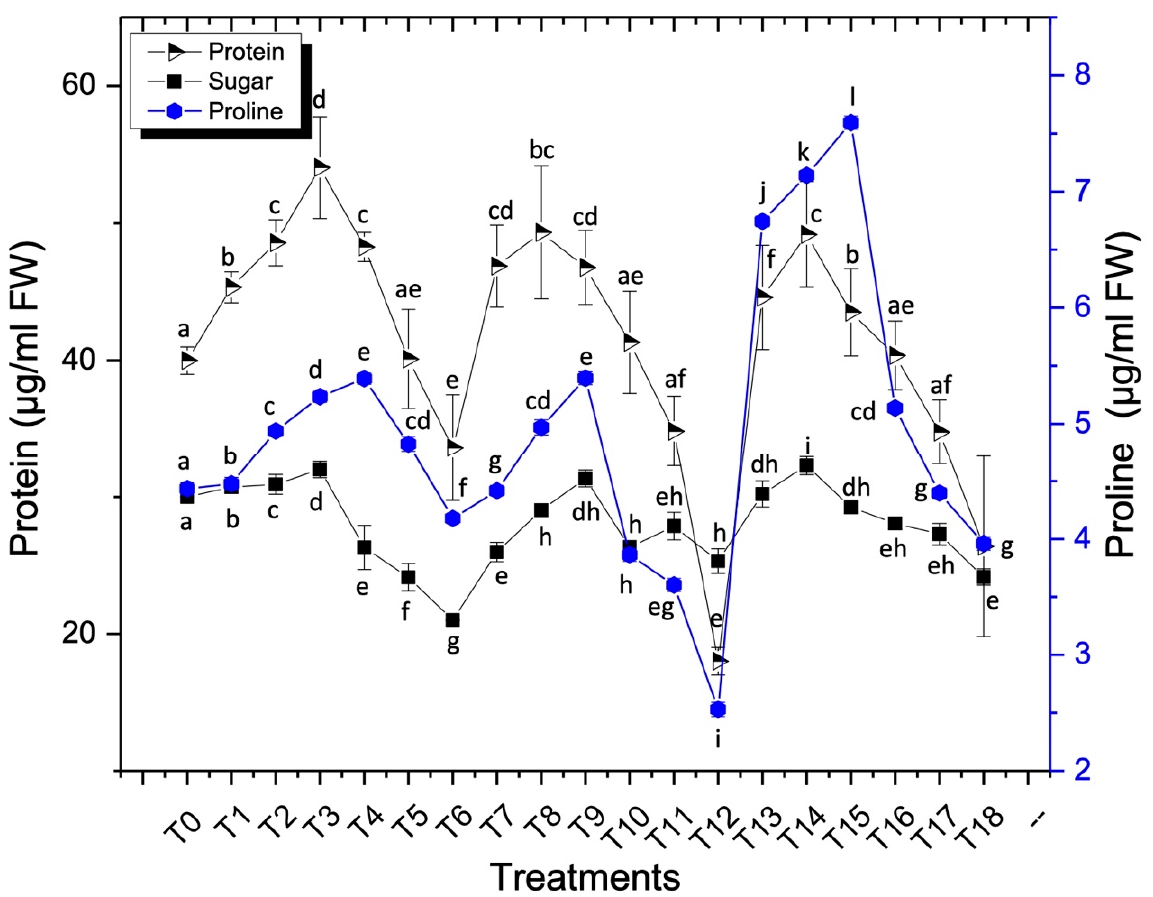
Figure 6. Effects of different treatments of AgNPs on protein, proline and soluble sugar contents of sunflower. Lowercase letters differed significantly at 5% probability levels, using Duncan’s Multiple Range Test ( p < 0.05).